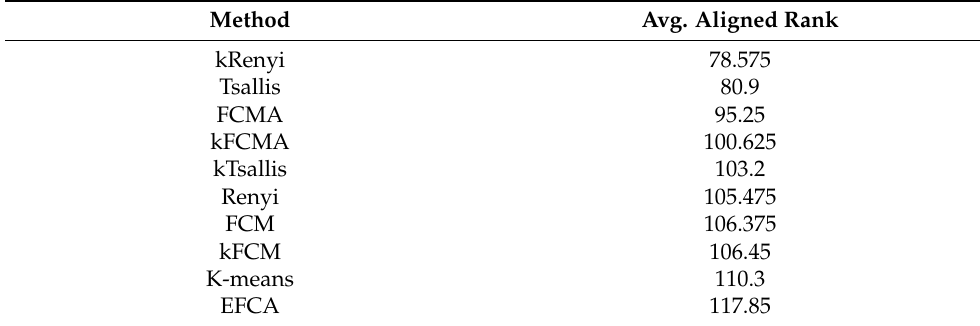
Table 6. Average aligned ranks of the compared methods in the Friedman aligned rank test.